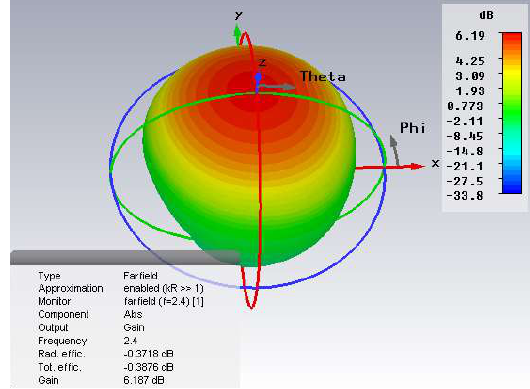
Figure 14: Spice circuit for patch antenna without